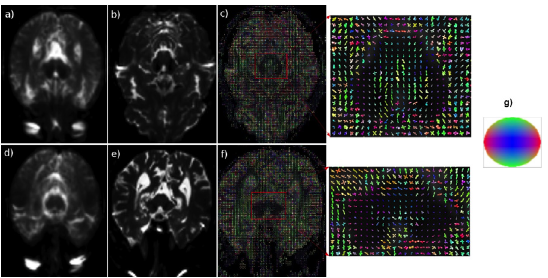
Fig 1. Template Brain map (EAP field). (a) and (b) are the corresponding S 0 (zero magnetic gradient) slices of the constructed template brain map and a control, respectively. (c) The template EAP field of the same slice as in (b), with the ROI containing the Substantia Nigra (SN). (d) and (e) The corresponding S0 slices of the template and a PD patient, respectively, and (f) shows the template EAP field computed for the slice in (e), with the ROI containing the SN. (g) is the color ball used to denote the directions in the EAP